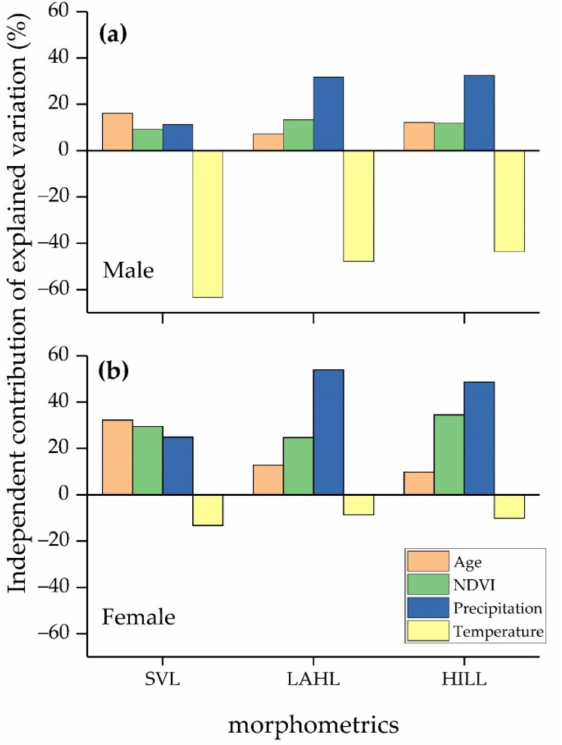
Figure 4. Independent contribution for each biological and environmental effect on Rana kukunoris morphometrics. ( a ) Effects on male morphometrics; ( b ) effects on female